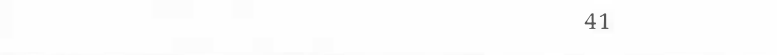
Figure 4 The early horse-and-rider stat­ uette from Horizon 4 at Tango Maare Dia­ bal, height 15 cm; conserved by Bethan Baresi at the Institute of